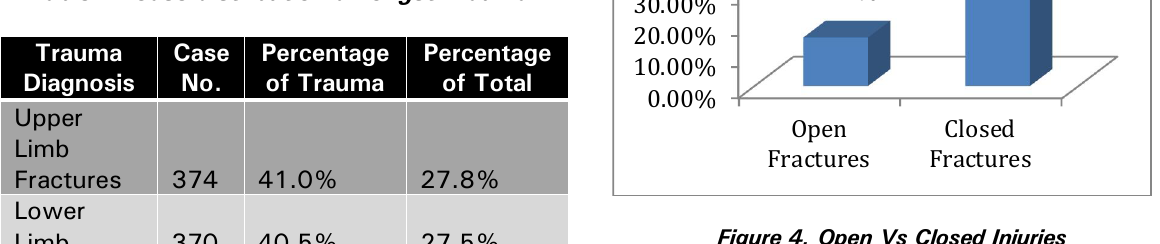
Table 1: Case distribution amongst Trauma